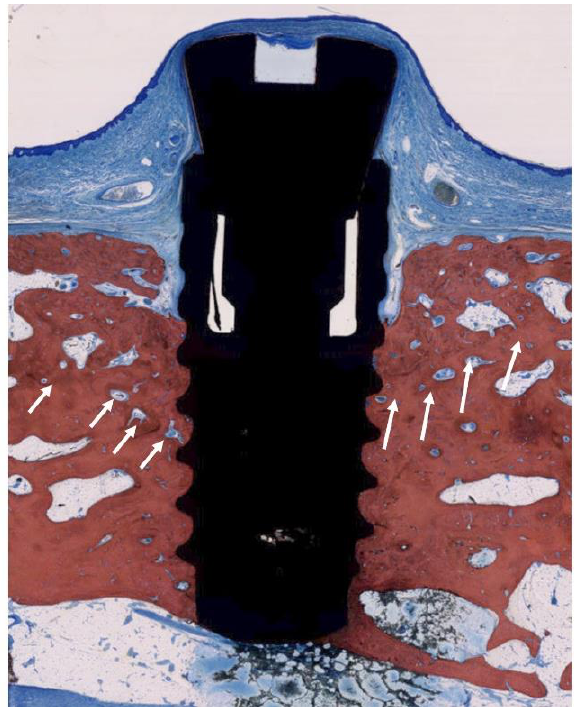
Figure 6. Histologic evaluation of healing after classical cleaning (CC) (SLA ® surface). The arrows indicate the bony crest before treatment. Bone-to-implant contact was achieved but full regeneration could not be achieved in any implant.